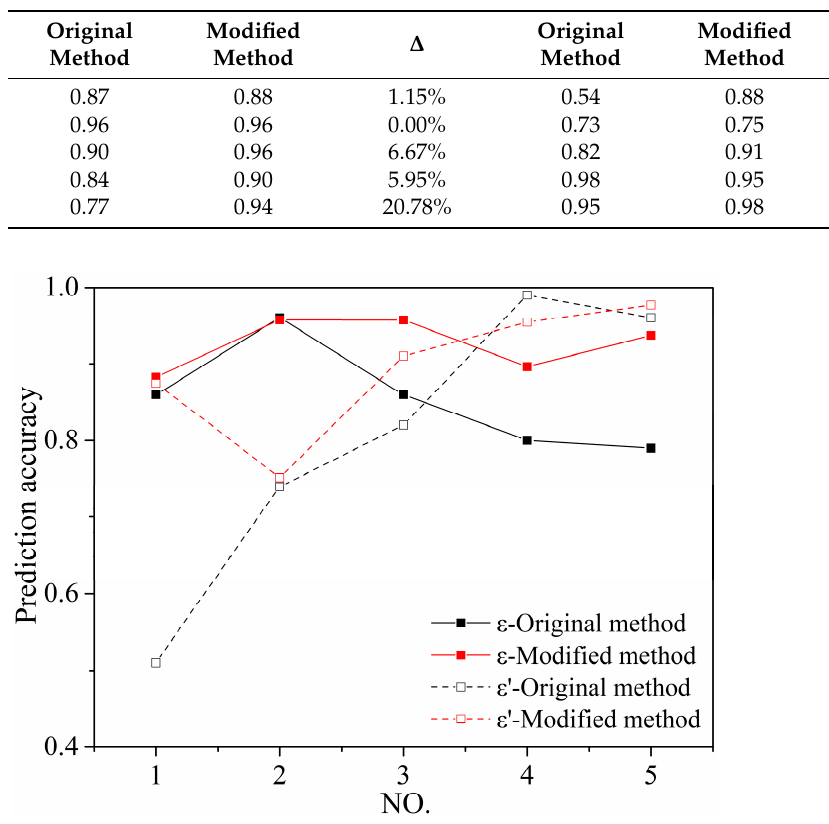
Table 16. The prediction accuracies of the original and modified methods.